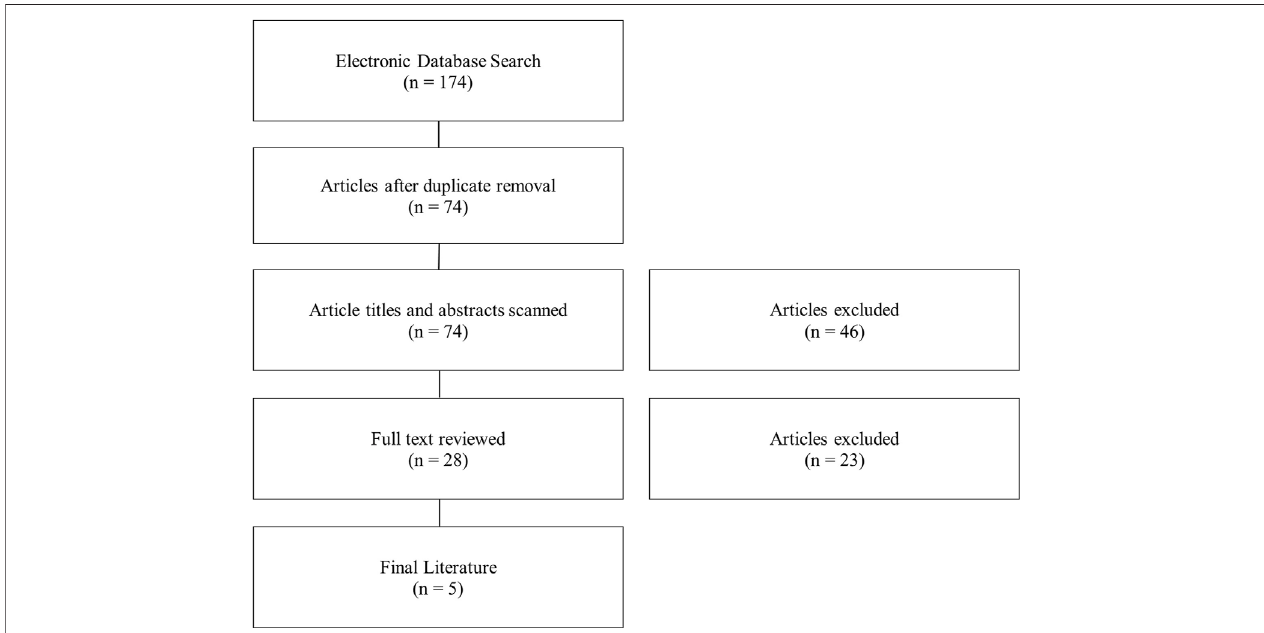
FIGURE 1 | Flow diagram of literary search strategy and eligibility.